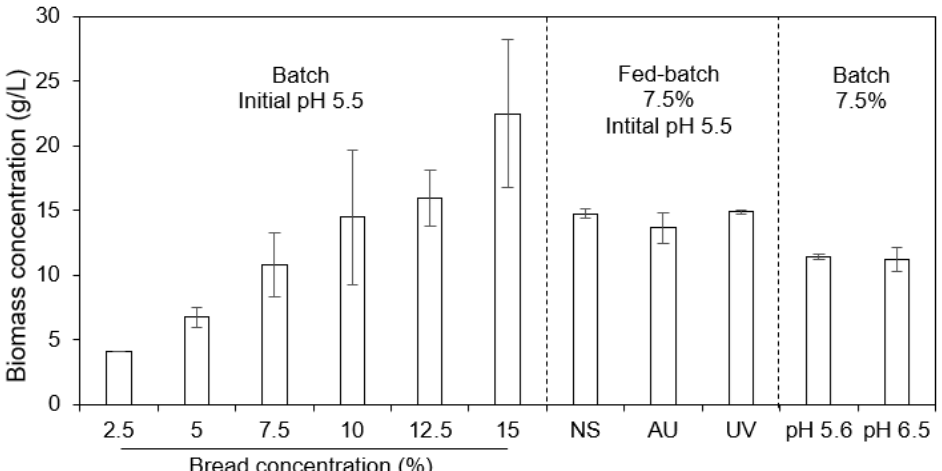
Figure 2. Biomass concentrations for cultivation in shake flasks under the batch, fed-batch, and varied initial pH conditions. The sterilization mode of the substrate (final concentration of 7.5%) under the fed-batch condition is indicated with NS: no sterilization, AU: sterilization in an autoclave, and UV: sterilization with UV.